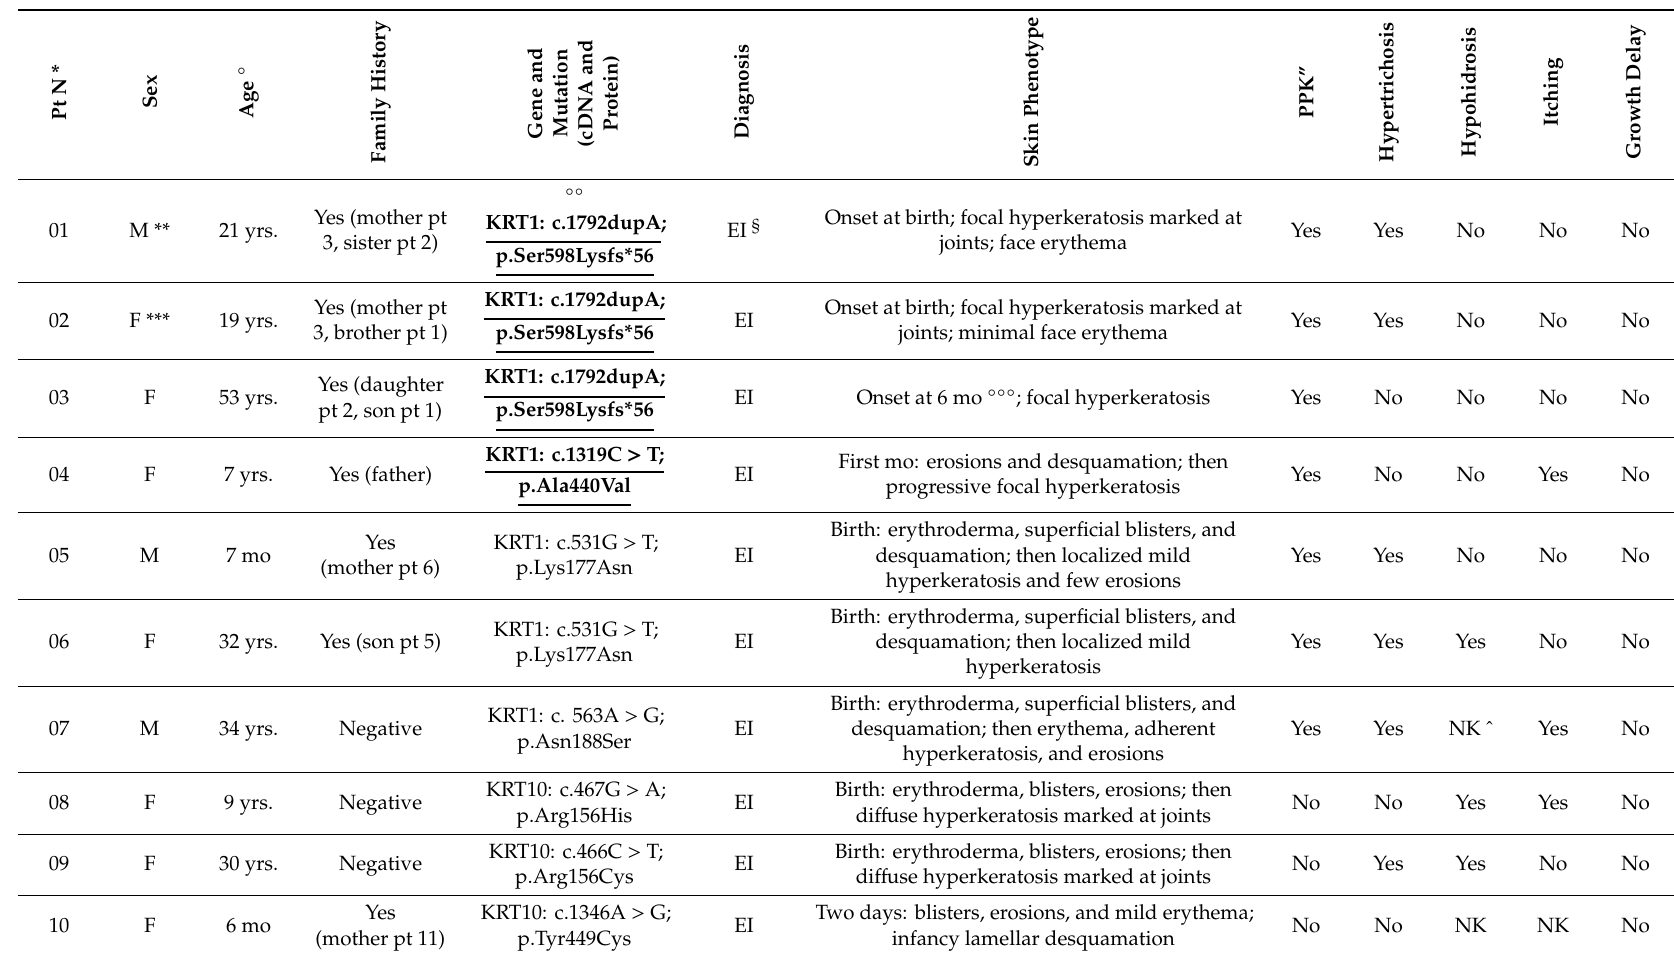
Table 1. Clinical and molecular features of 26 keratinopathic ichthyosis